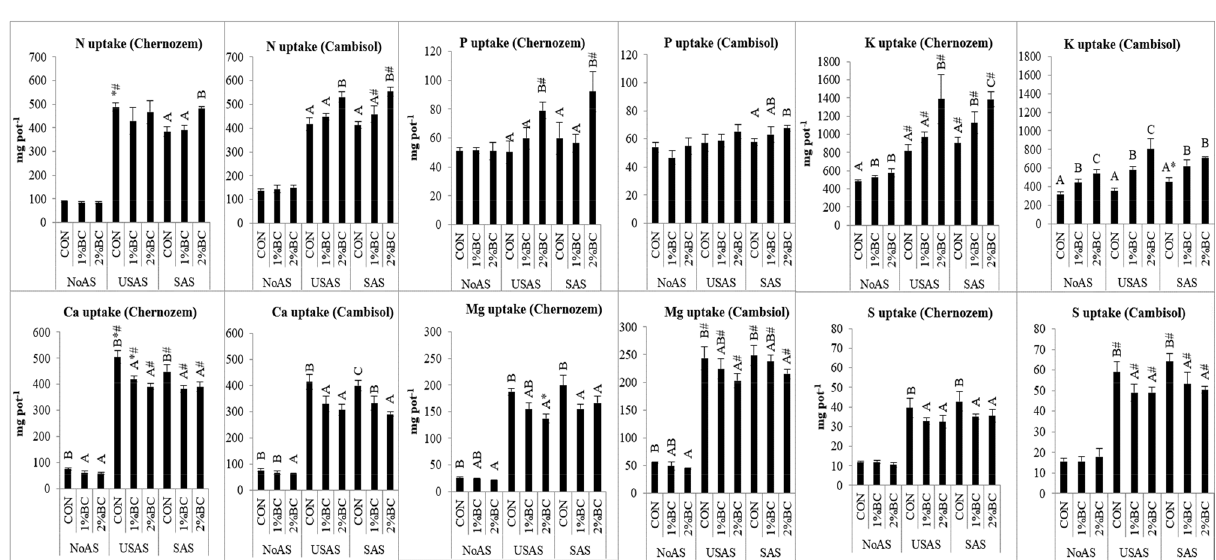
Figure 2. The uptake nutrients (N, P, K, Ca, Mg and S) by aboveground biomass of maize as affected by biochar, USAS (un-stabilized ammonium sulphate) and SAS (stabilized ammonium sulphate with DMPP). Different upper-case letters indicate a significant difference between variants within the same treatments of the same soil. *Represents a significant difference along biochar treatments of SAS and USAS (pair wised t-test between 1% BC of USAS and 1% BC of SAS and between 2% BC of USAS and 2% BC of SAS). # Represents significant difference of pair wise t-test along different soils of similar treatments (CON of USAS Chernozem with CON of USAS Cambisol and likewise). NoAS No ammonium sulphate, CON control, 1% BC 1% biochar, 2%BC 2%